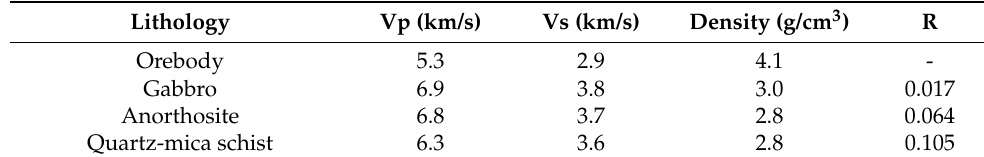
Table 1. Rock properties used in models A–C. Properties are from [58].